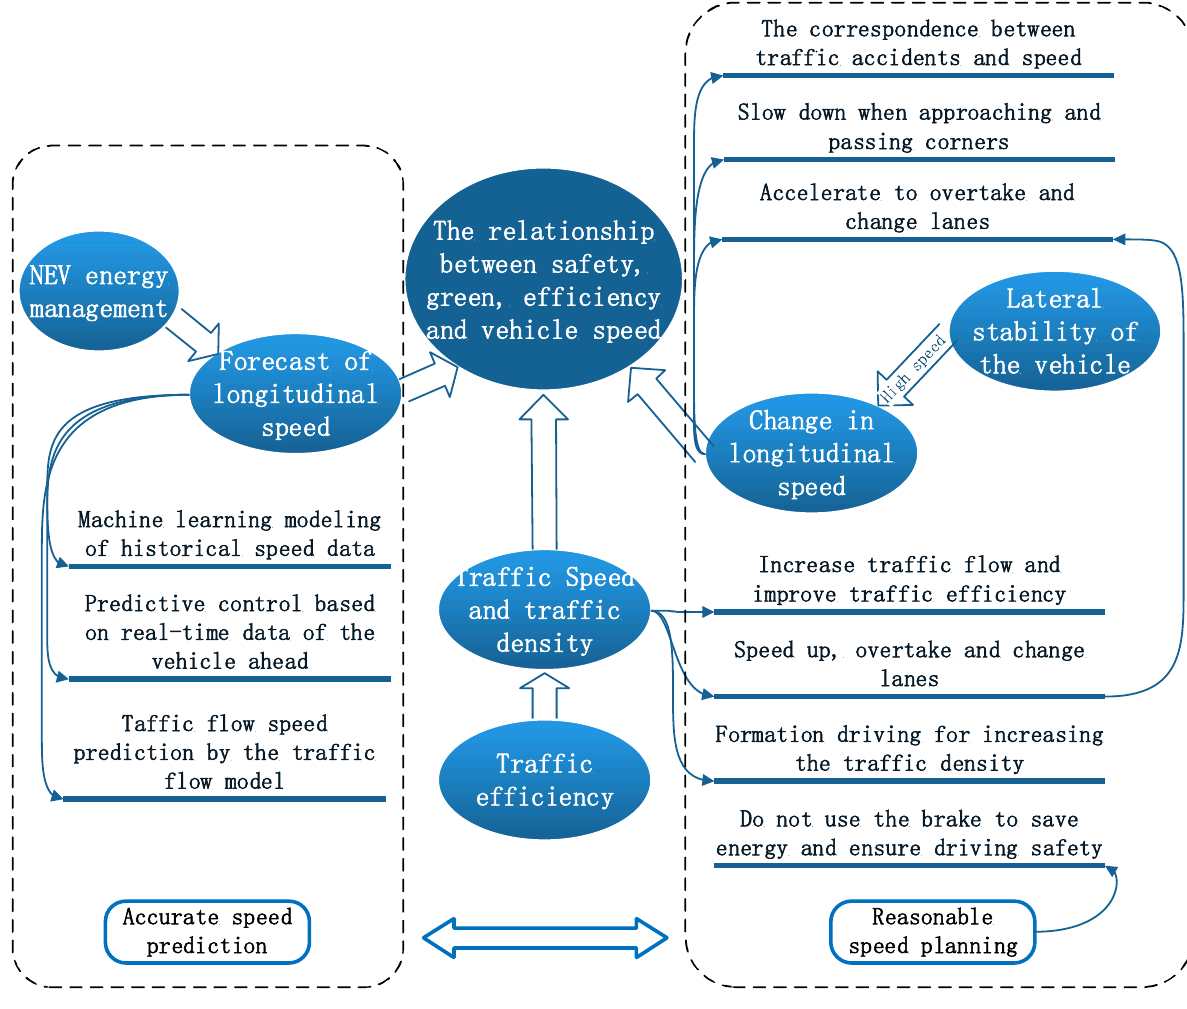
Figure 1. The relationship between “safety”, “efficiency”, “green”, and speed of intelligent networked vehicles. The automobile industry is now undergoing an electrification revolution. Take China as an example, in 2018, the production and sales of NEVs reached 1.27 million and 1.256 million units, respectively. In 2019, the production and sales of NEVs reached 1.242 million units and 1.206 million units, respectively. From January to December in 2020, the